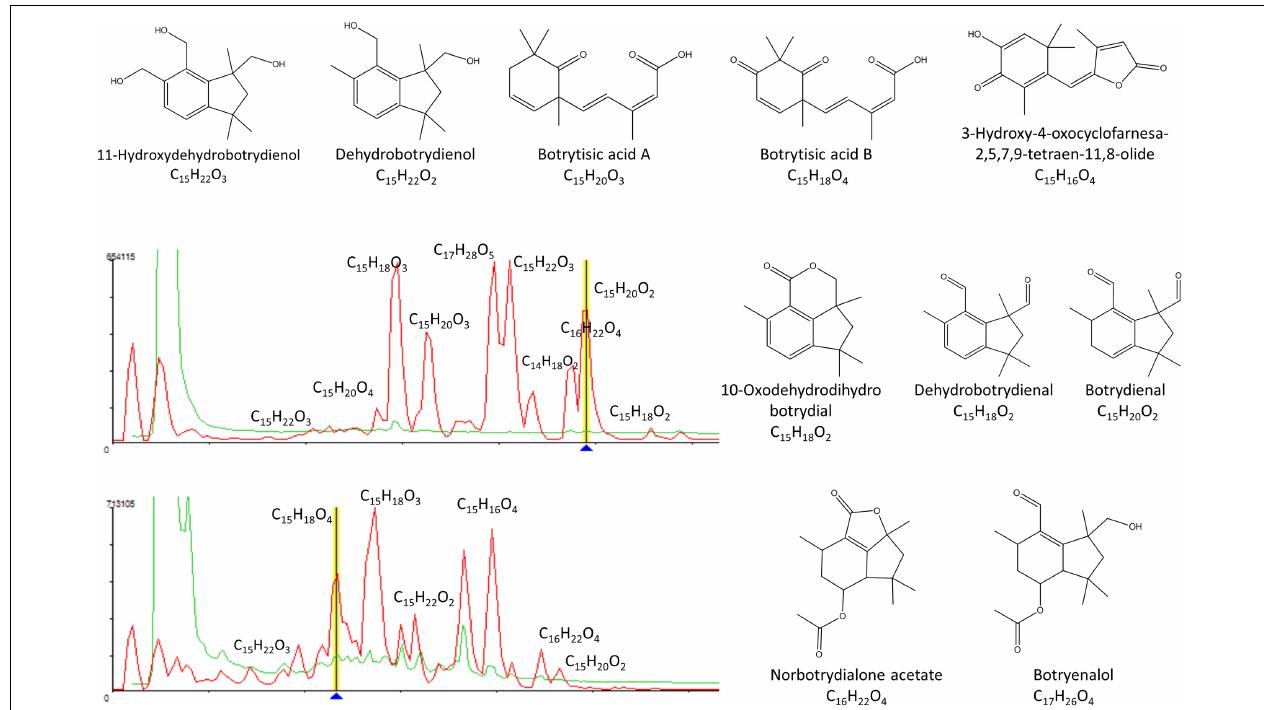
FIGURE 4 | Tentative identification of secondary metabolites induced in B. cinerea as a response to the microbial interactions.